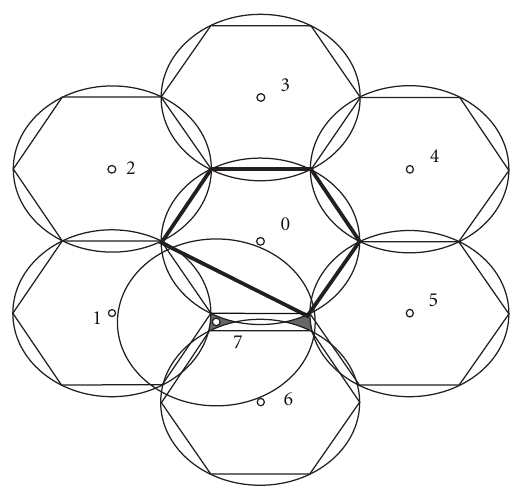
Figure 3: Largest possible closed packed cluster size is 3